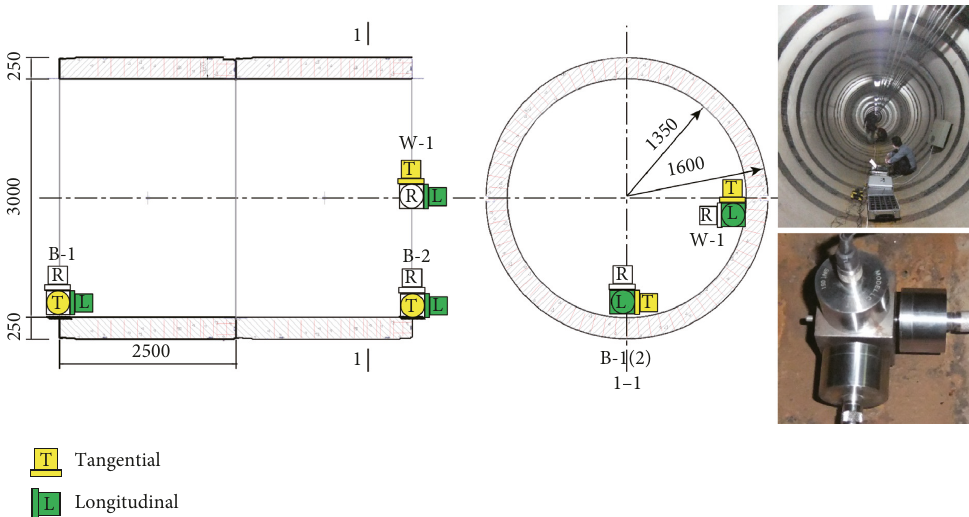
Figure 2: Arrangement map for the site measurement at the Xizang Road power tunnel.